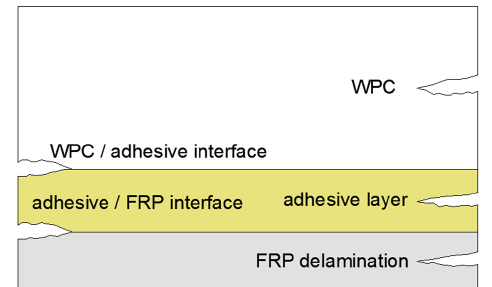
Fig. 1 . Five possible failure